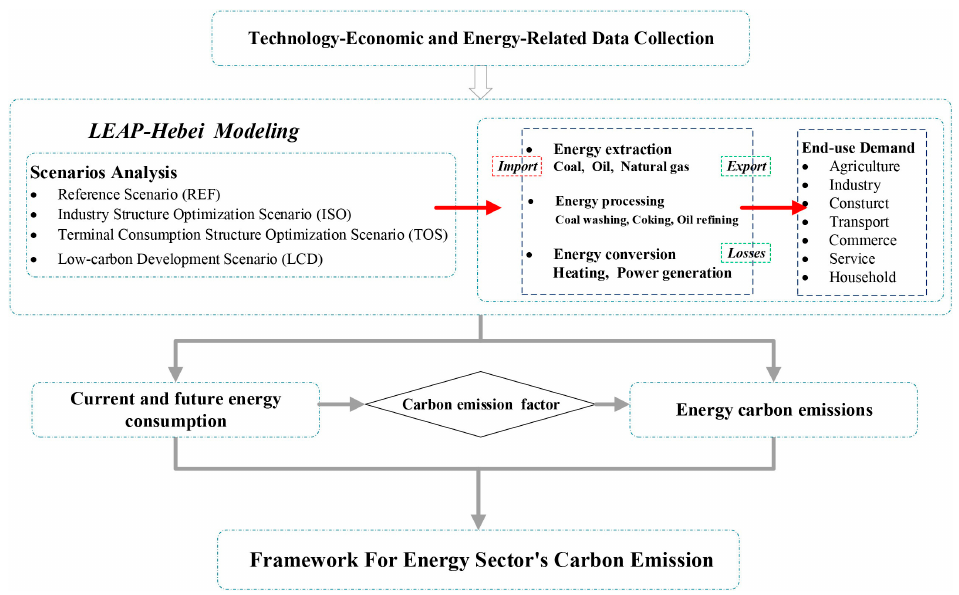
Figure 2 . Model framework used to assess the carbon emissions of the energy sector. In the LEAP-Hebe, four scenarios: a Reference Scenario (REF), Industrial Structure Optimization Scenario (ISO), Terminal Consumption Structure Optimization Scenario (TOS) and Low-carbon Development Scenario